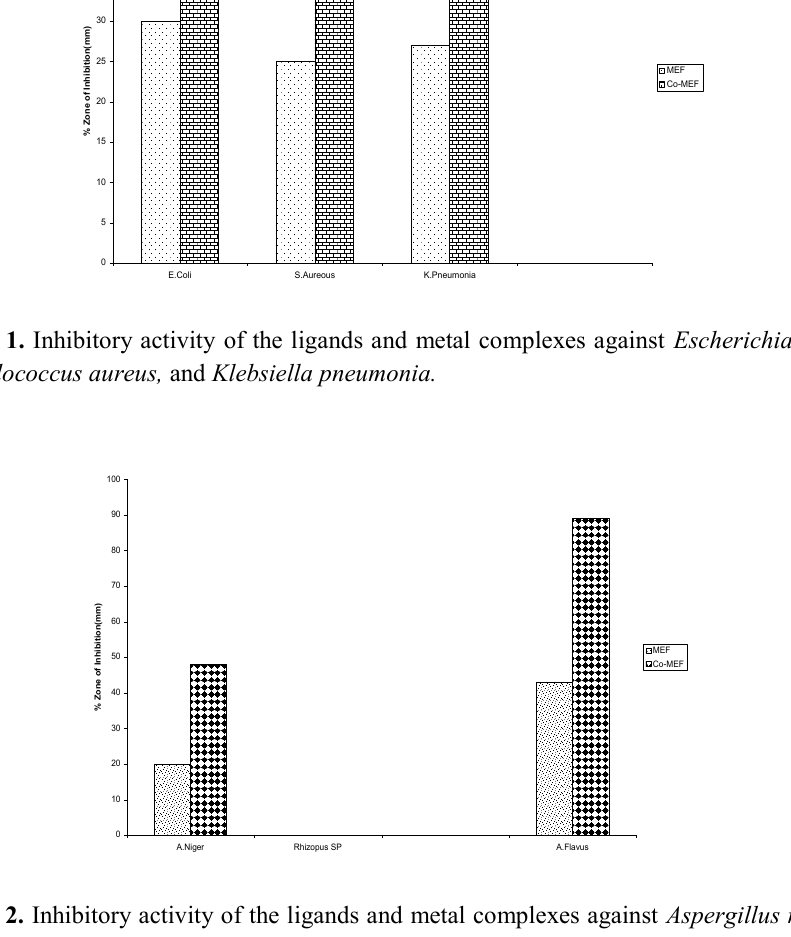
Figure 2. Inhibitory activity of the ligands and metal complexes against Aspergillus niger, Rhizopus species, and Aspergillus